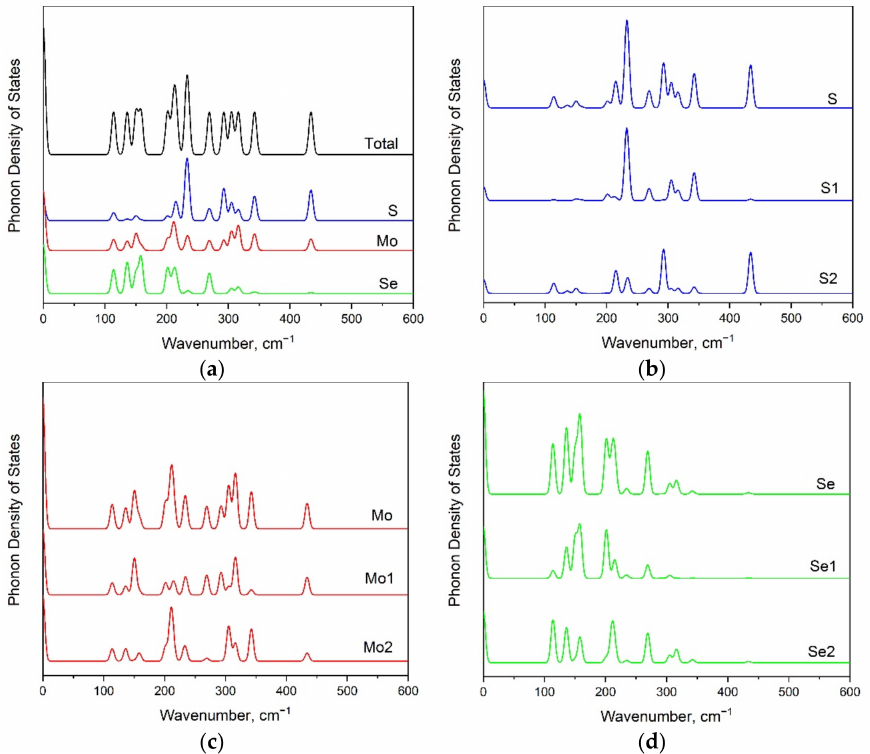
Figure 7. The phonon density of states for 1T’-MoSSe modification ( a ) including partial contributions of each S ( b ), Mo ( c ), and Se ( d ) ions.